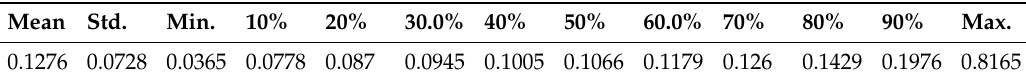
Table 5. Statistics of the Jaccard similarity using the 100 most similar movies for each movie. Mean